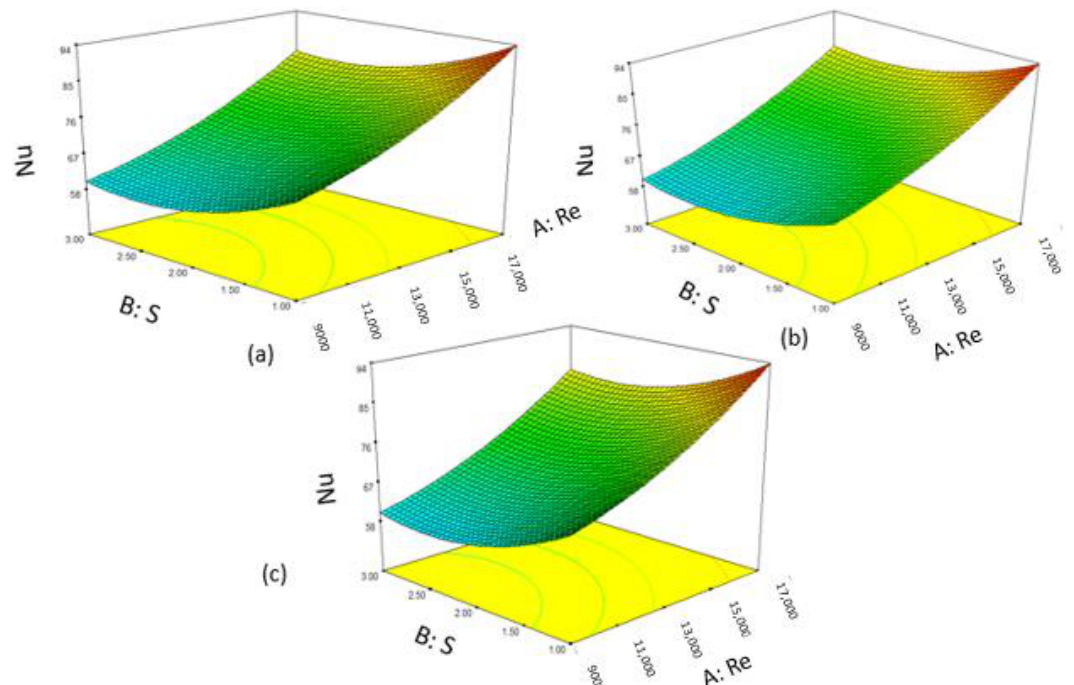
Figure 8. Nusselt number contours and 3D surface formed by the effect of Reynolds number and frequency at the optimum conditions for the optimization target of maximum Nusselt number and nanoconcentration equal to ( a ) 0.1% M; ( b ) 0.5% M; ( c ) 1% M. Energies 2021 , 14 , x FOR PEER REVIEW